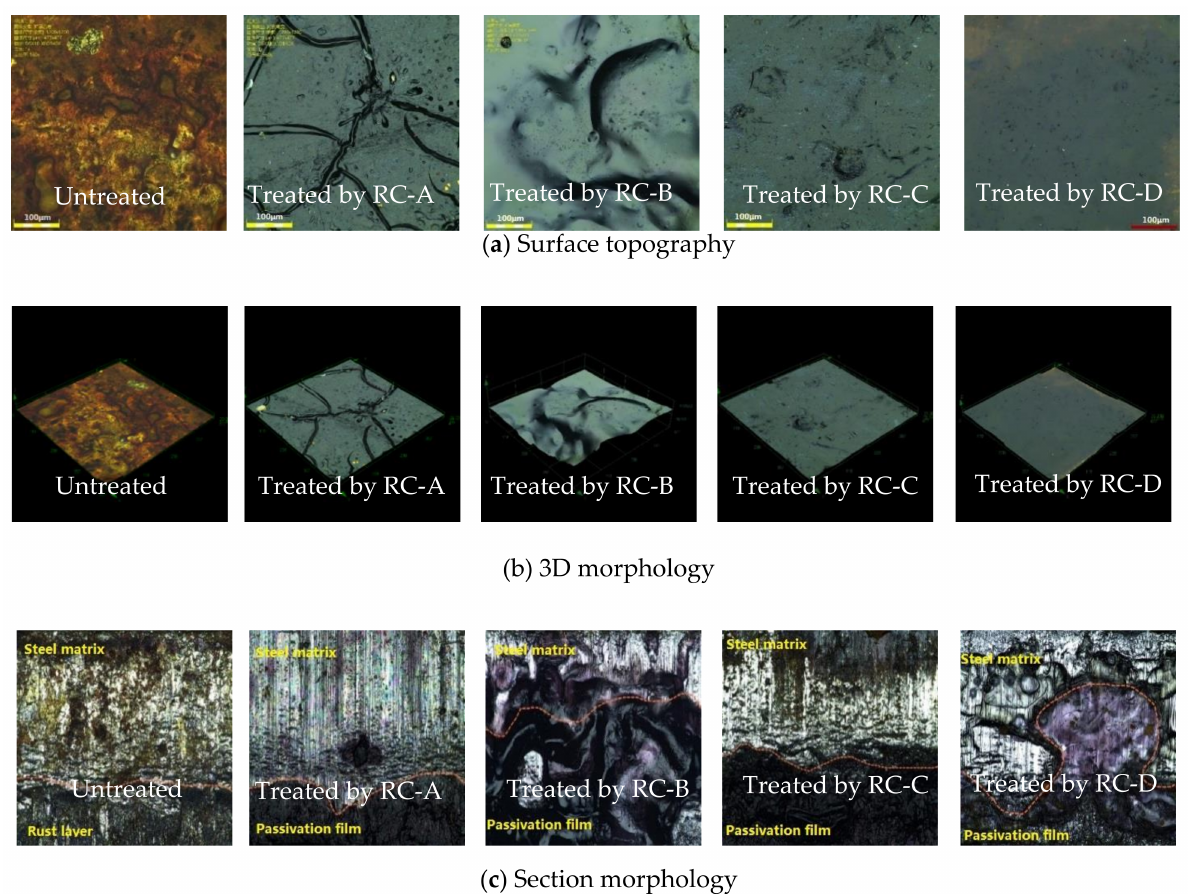
Figure 2. Morphology of rusty steel sheets treated with RC-A, RC-B, RC-C, and RC-D ( ×